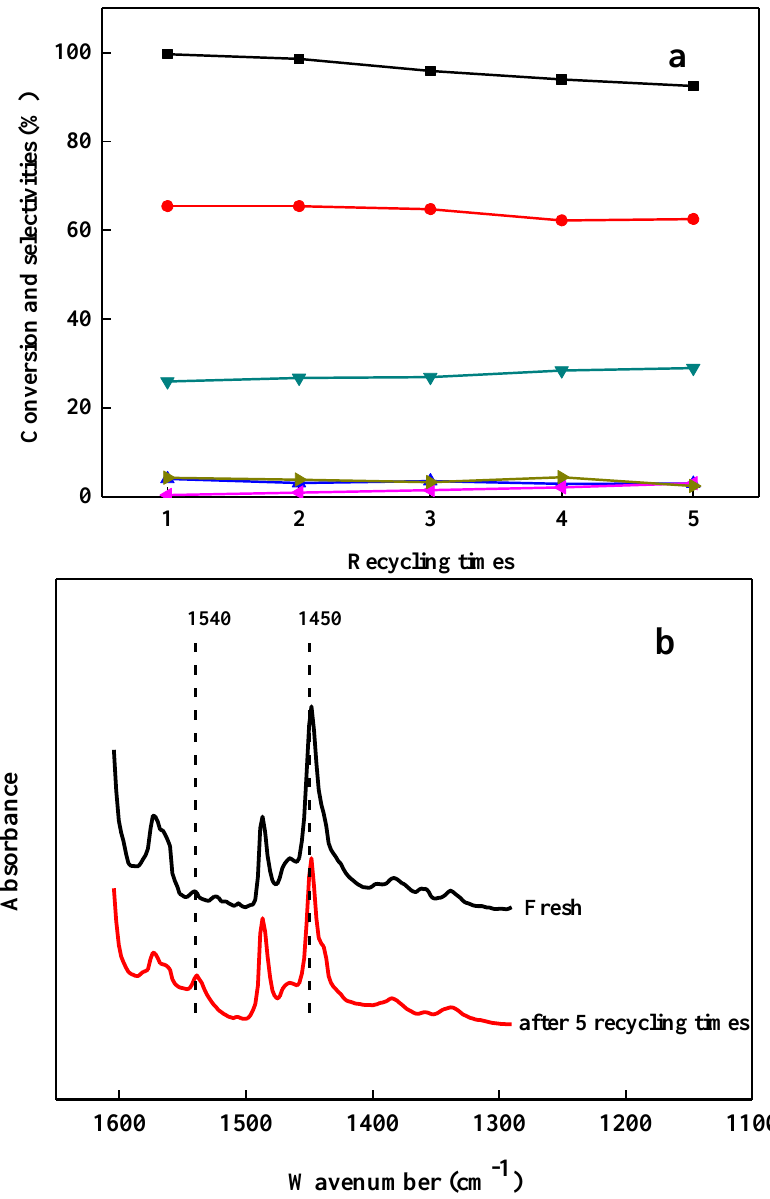
Figure 6. ( a ) Recycling performance of the [BMIM]Cl-2ZnCl 2 ionic liquid catalyst in the chlorination of toluene with gaseous Cl 2 . ■ , conversion of toluene; ●, selectivity of o -chlorotoluene; ▲ , selectivity of m -chlorotoluene; ▼ , selectivity of p -chlorotoluene; ◄ , selectivity of benzyl chloride; ► , selectivity of dichlorotoluenes. Reaction conditions: toluene, 0.5 mol; chlorine, 25 mL min −1 ; [BMIM]Cl-2ZnCl 2 , 3 mol/100 mol toluene; reaction temperature, 80 °C; reaction time, 8 h; ( b ) FT–IR spectra of pyridine/fresh [BMIM]Cl-2ZnCl 2 ionic liquid and pyridine/spent [BMIM]Cl-2ZnCl 2 ionic liquid recycled for 5 times. The volume ratio of pyridine to ionic liquid is 1:1.